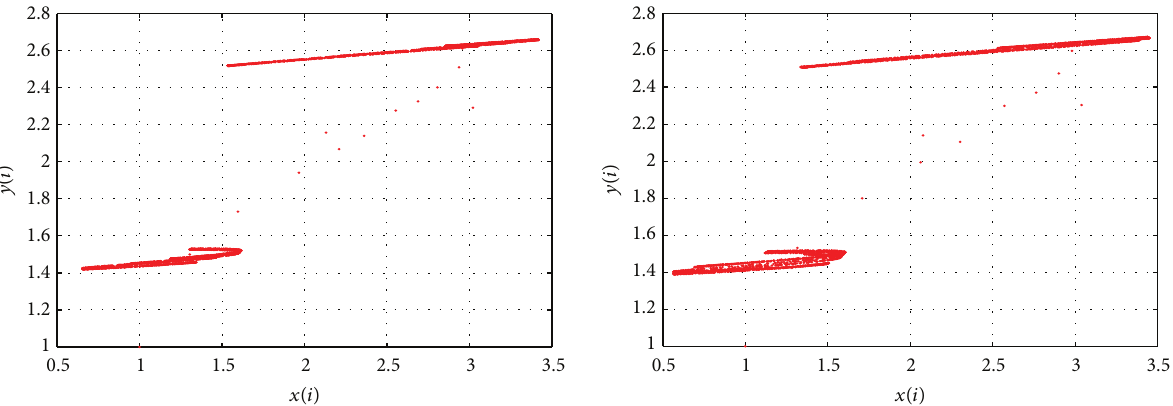
Figure 5: The portraits for several values of 𝐴 1 = 0.03 , 𝛿 = 5.7 , and 𝛿 = 5.75 .